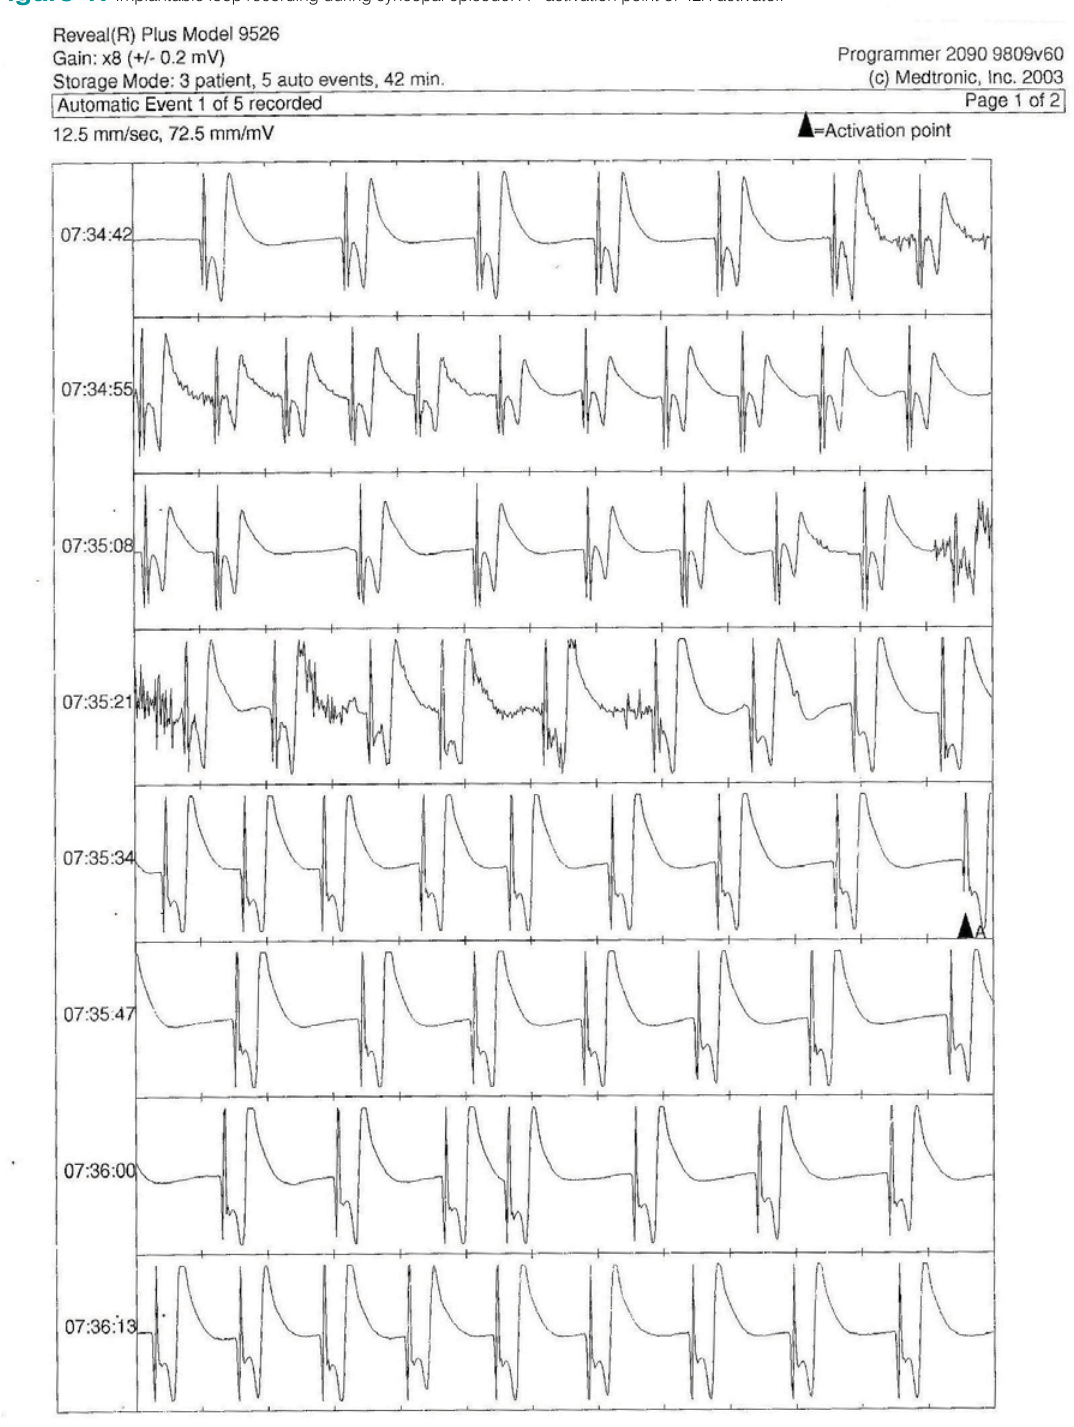
Figure 1. Implantable loop recording during syncopal episode. A - activation point of ILR